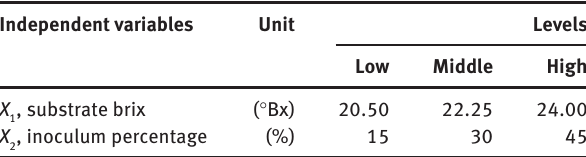
Table 1: Fermentation conditions and their